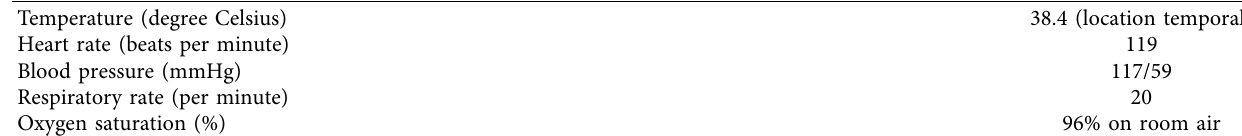
Table 2: Vital signs.